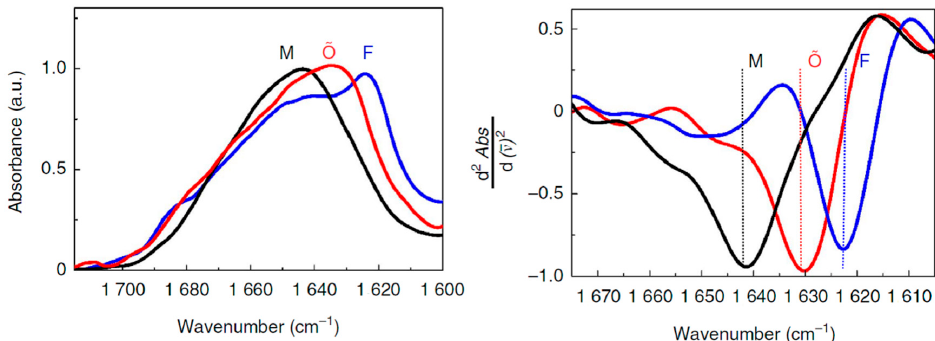
Figure 2. Left panel : normalized FTIR spectra of A β 1–40 monomers (M) in 10 mM HEPES/D 2 O pD11, fibrils (F) after 24 h incubation in 10 mM HEPES pD7.4, and Cu(II)-induced oligomers (A β 1–40 -Cu(II)Õ) after 24 h incubation at 37 °C, pD7.4 [51]. Right panel : second derivatives of the FTIR spectra. Reprinted with permission.